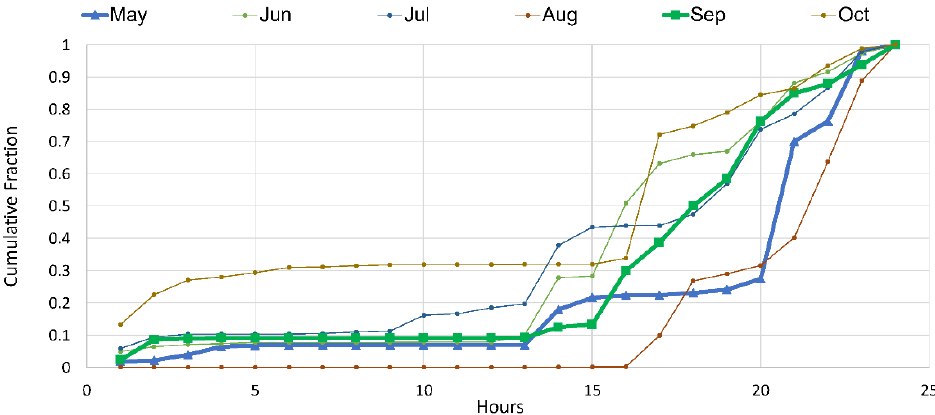
Figure 8. Cumulative hourly distribution of the 24-h design storm for the rainy season months.